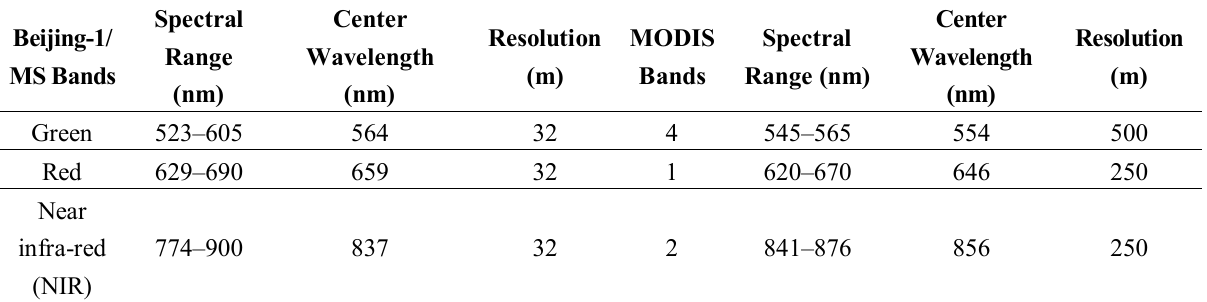
Table 2. Main characteristics of Beijing-1/MS and Terra/MODIS